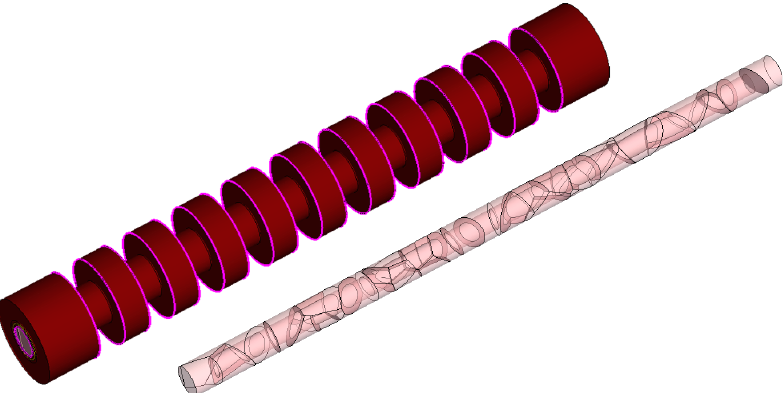
Figure 2. Pictorial view of a ten-cell memory string ( left ) and of the inner polysilicon regions separated into polycrystalline grains ( right ). The example is the result of a TCAD simulation of the cell structure where polysilicon grains are obtained via Voronoi tessellation of the silicon